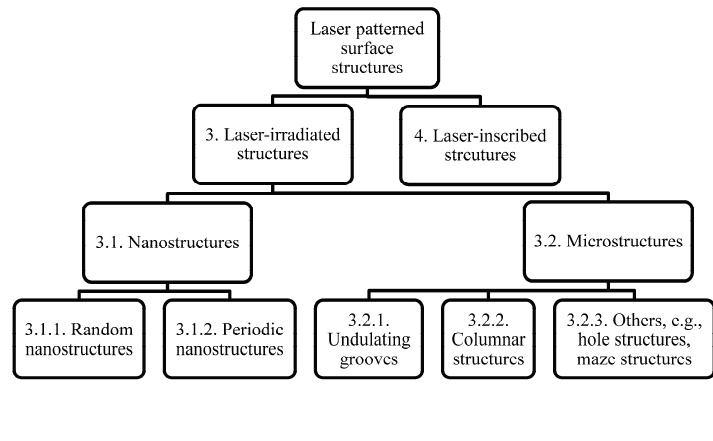
Figure 3. Classification of laser-patterned surface structures.